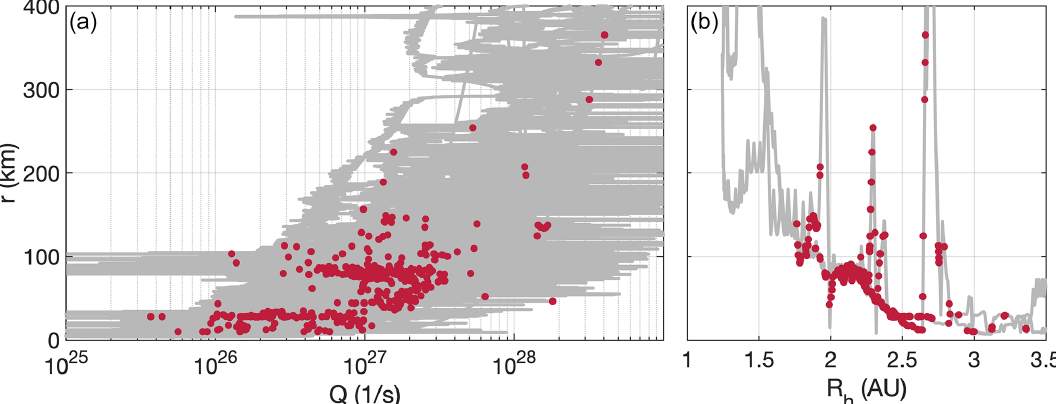
Figure 3. Cometocentric distance of the spacecraft over gas production rate (a) and heliocentric distance (b) . The gas production rate was derived from measured neutral-gas densities using a spherically symmetric model. The grey lines show the position during the entire Rosetta mission, while the red dots indicate boundary